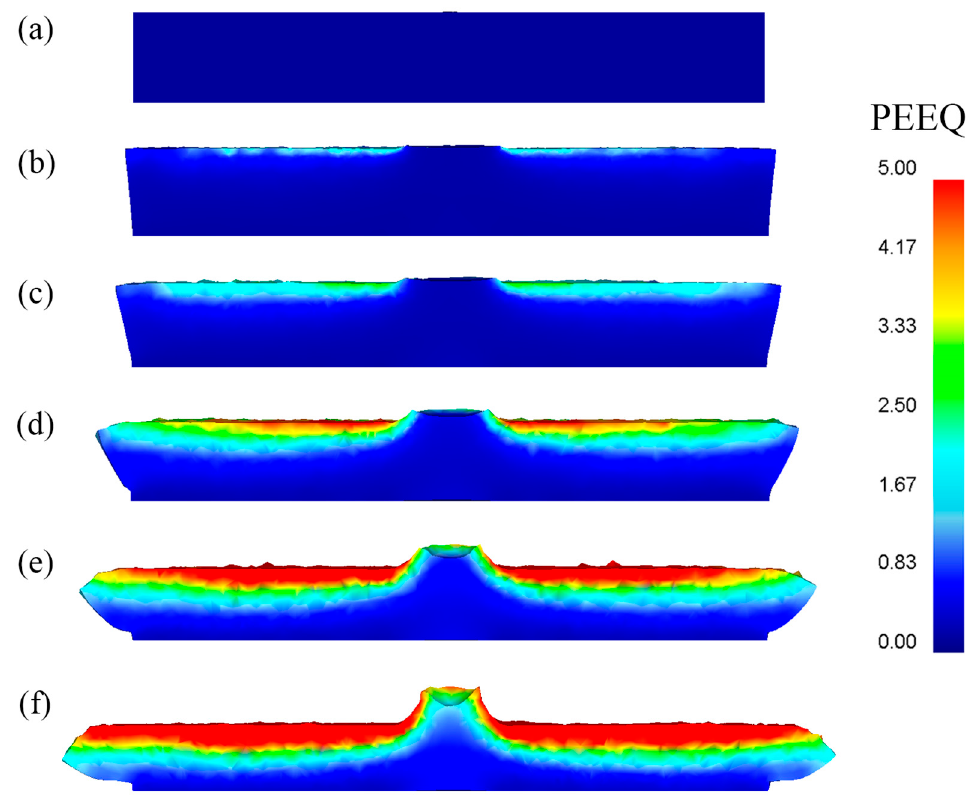
Figure 6. PEEQ distribution of axial section of disk workpiece with time. ( a ) t = 0 s; ( b ) t = 1.62 s; ( c ) t = 2.69 s; ( d ) t = 4.99 s; ( e ) t = 7.45 s; ( f ) t = 9.95 s.